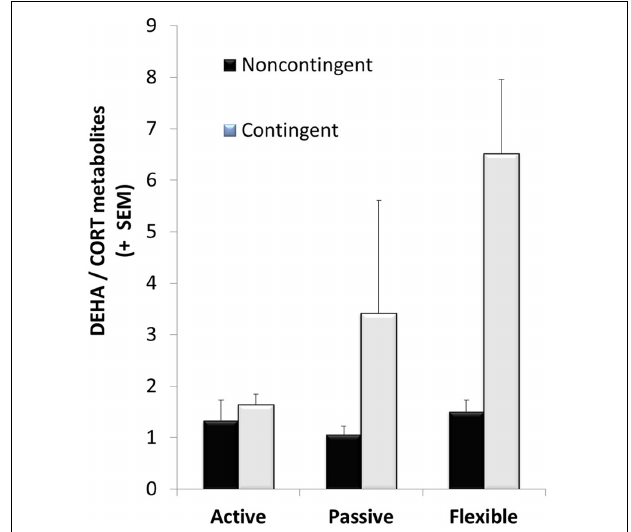
FIGURE 4 | DHEA/CORT metabolite ratios were differentially affected after the acquisition trial in the dry land maze; although there was high variabilityinthevaryingcopinggroups,onlyasignificantmaineffectfor contingencytrainingwasobserved(withmeanvaluesof3.69 ± 1.11and 1.29 ± 0.16 for the contingent and noncontingent groups, respectively). Although no significant interaction effect was observed, planned comparisons between contingent and noncontingent groups for each coping style revealed a significant training effect in the flexible coping